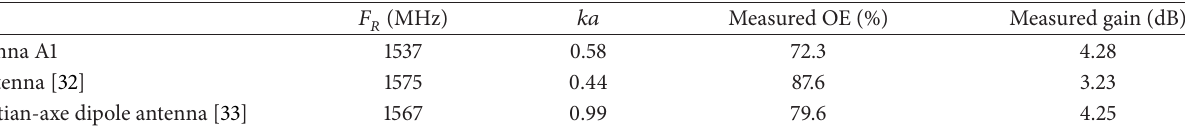
Table 3: Performance comparison of three electrical small metamaterial-inspired antennas.